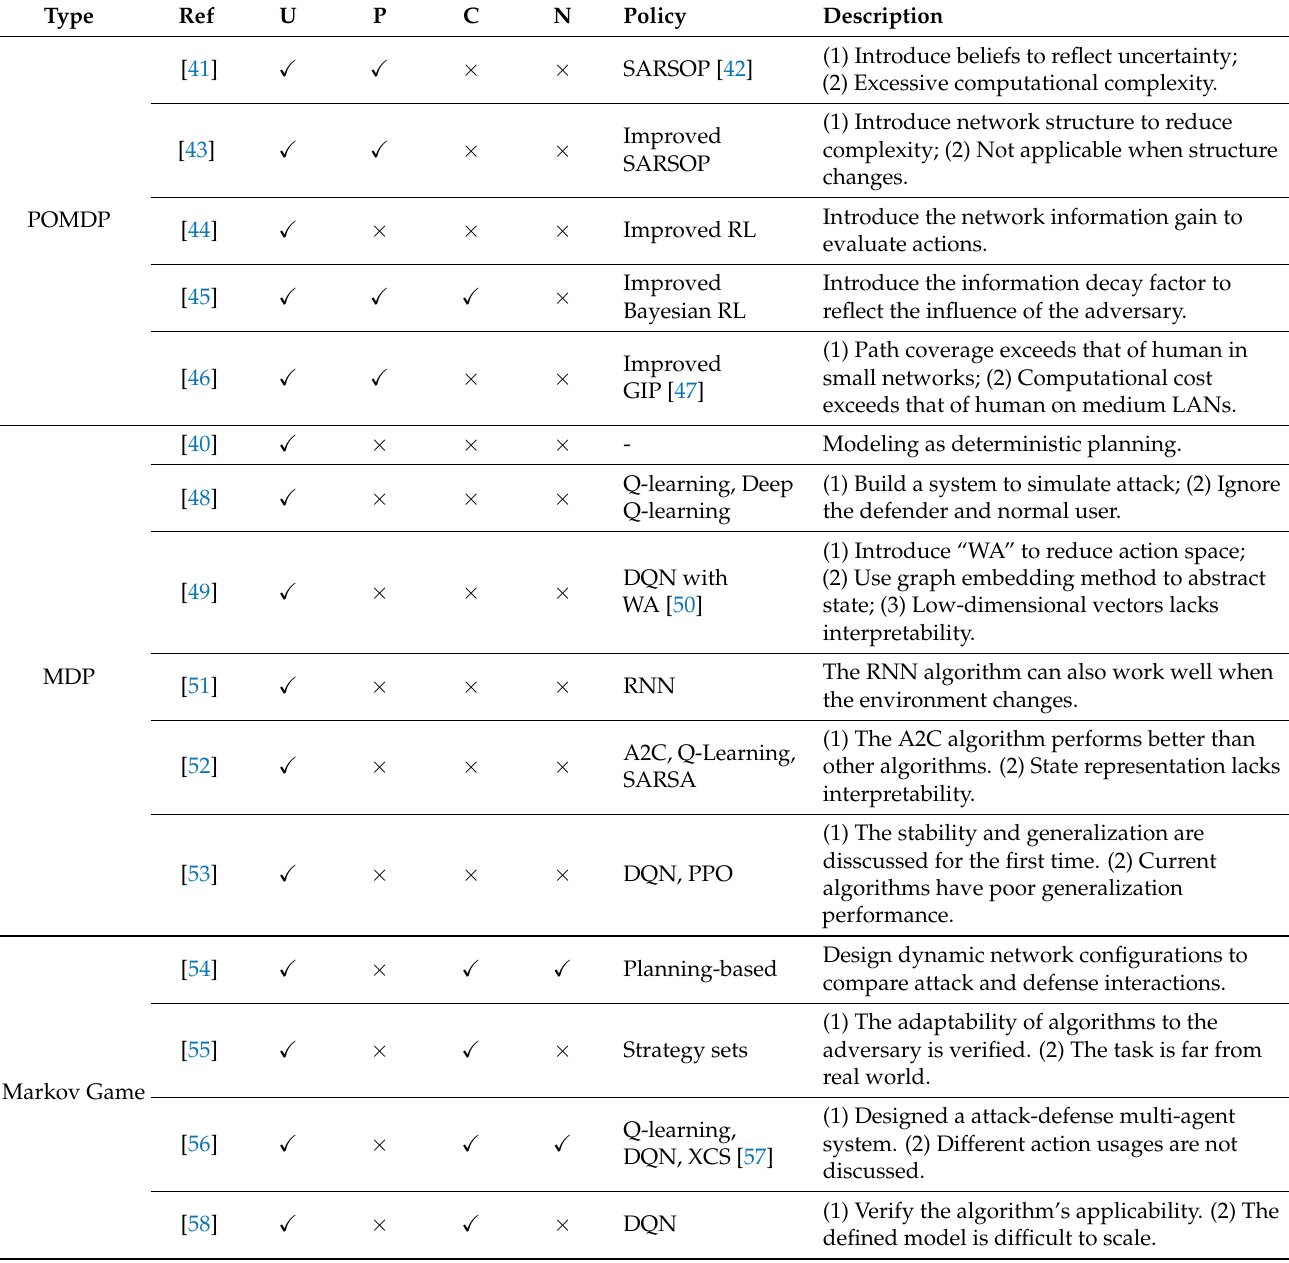
Table 1. Survey from the attacker’s